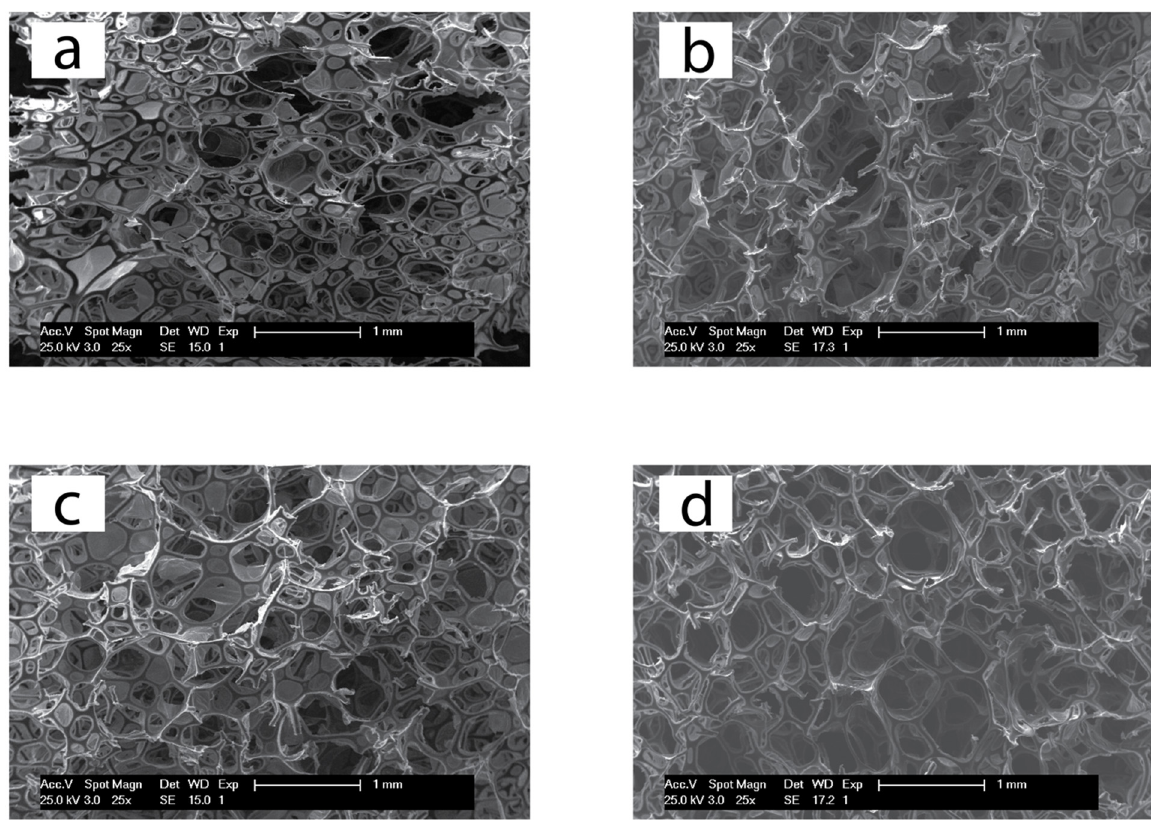
Figure 5. Representative SEM micrographs of foams with 0.2 php of the bismuth catalyst ( a , b ) and the stannous octoate catalyst ( c , d ). ( a , c ) Parallel and ( b , d ) perpendicular to the foaming direction.